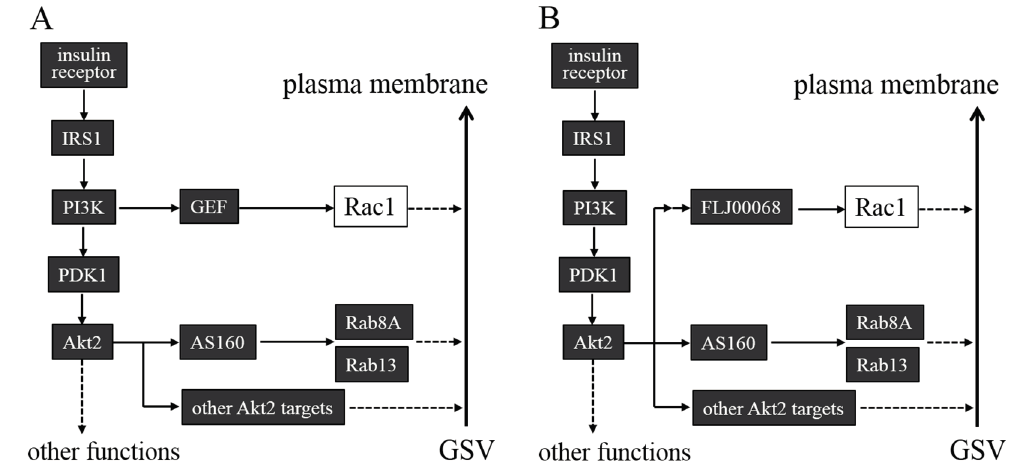
Figure 2. Proposed models for signaling pathways that direct translocation of GLUT4 from GLUT4 storage vesicles (GSVs) to the plasma membrane in skeletal